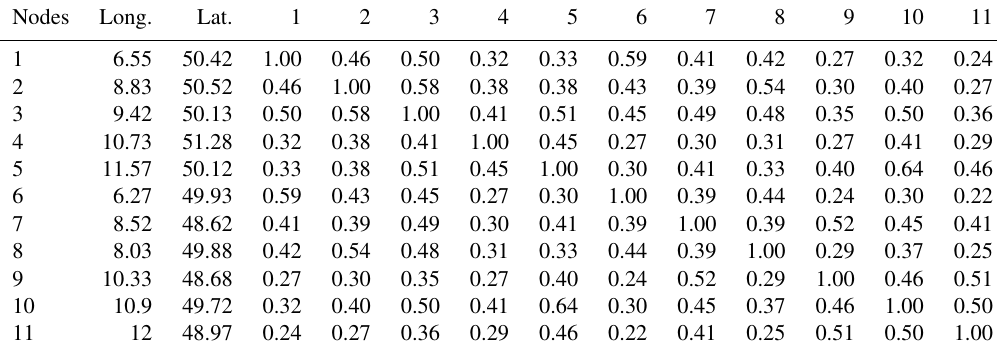
Table A1. Cross-correlation values along with the geographical location of 11 rain gauges selected for illustrative purposes. Nodes Long.